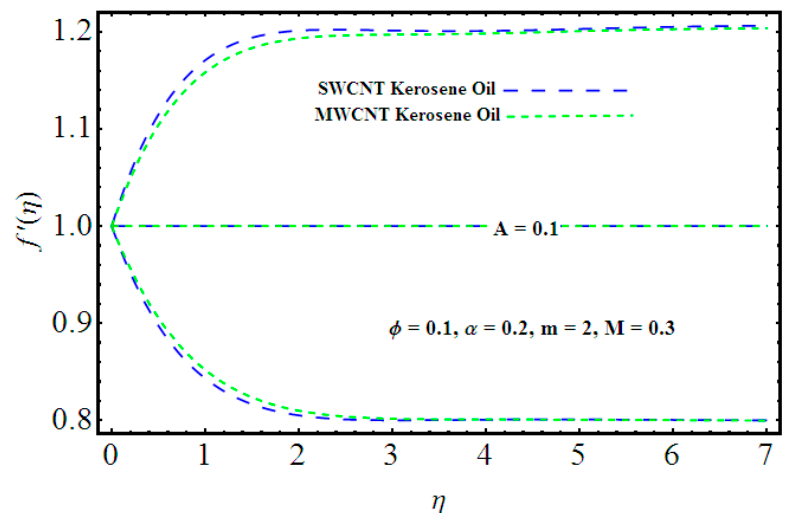
Figure 4. Impact of A on velocity 𝑓 (cid:4593) (𝜂) .